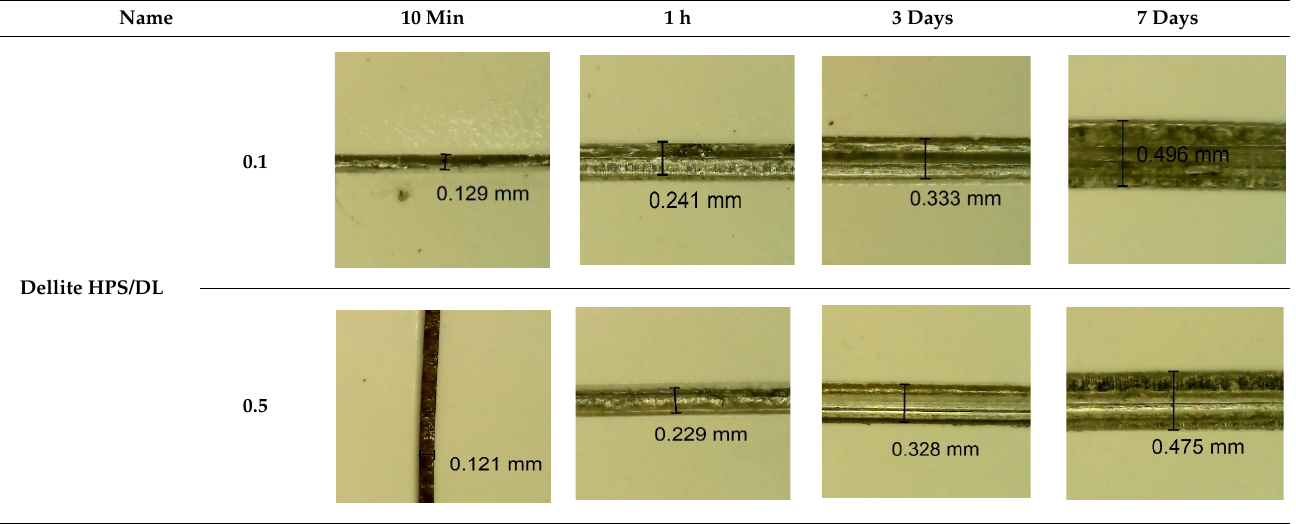
Table 5. Shrinkage of pressure-sensitive adhesives: marked with 0—adhesive without modification.